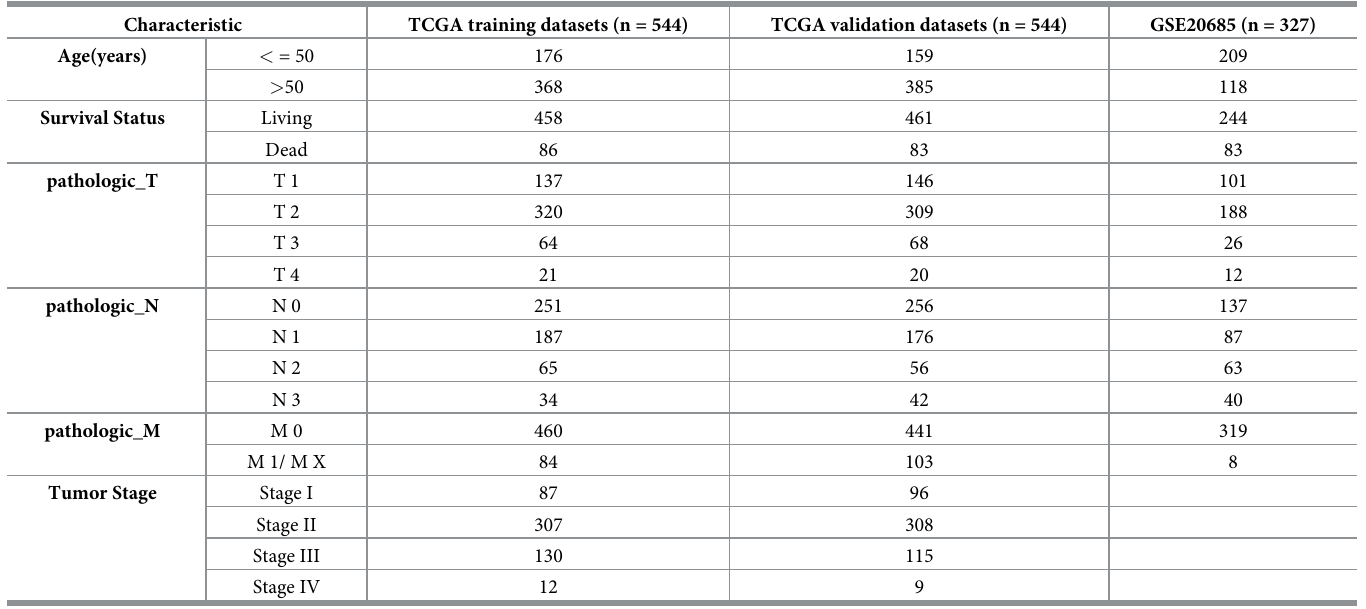
Table 1. Clinical information statistics of TCGA training datasets, TCGA validation datasets and GSE20685.